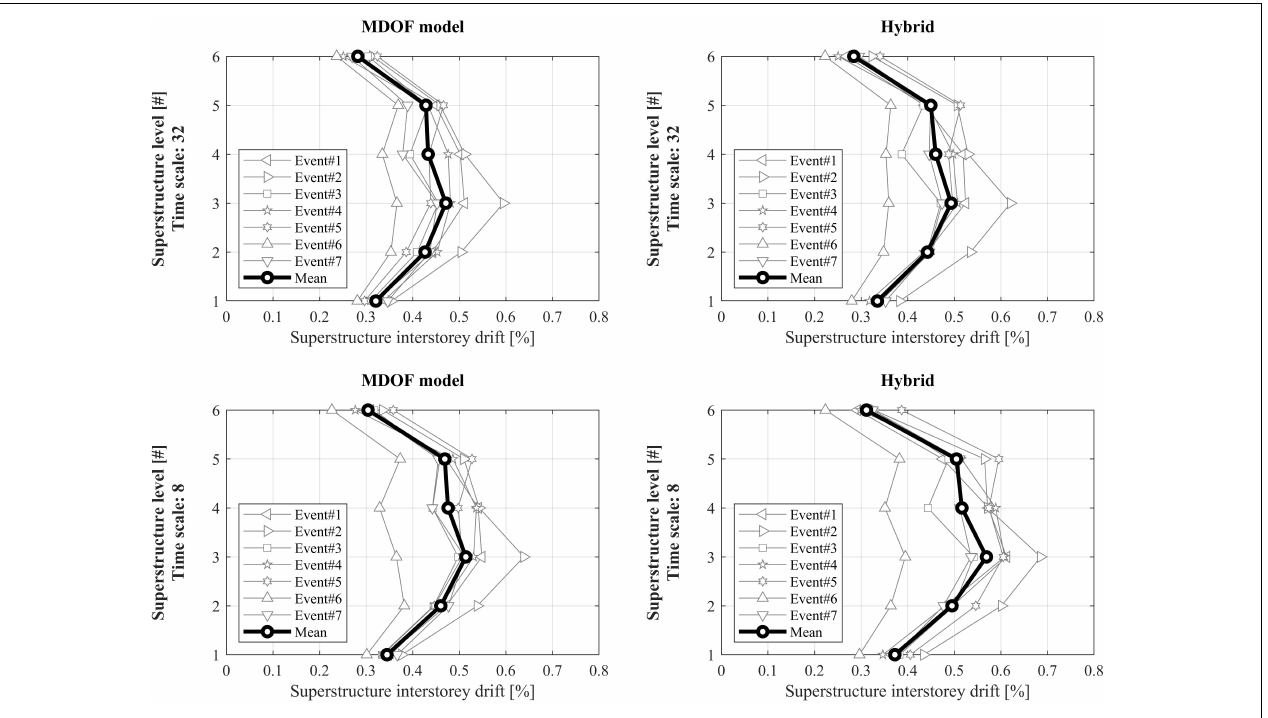
FIGURE 12 | Interstory drift response—time scales 32 and